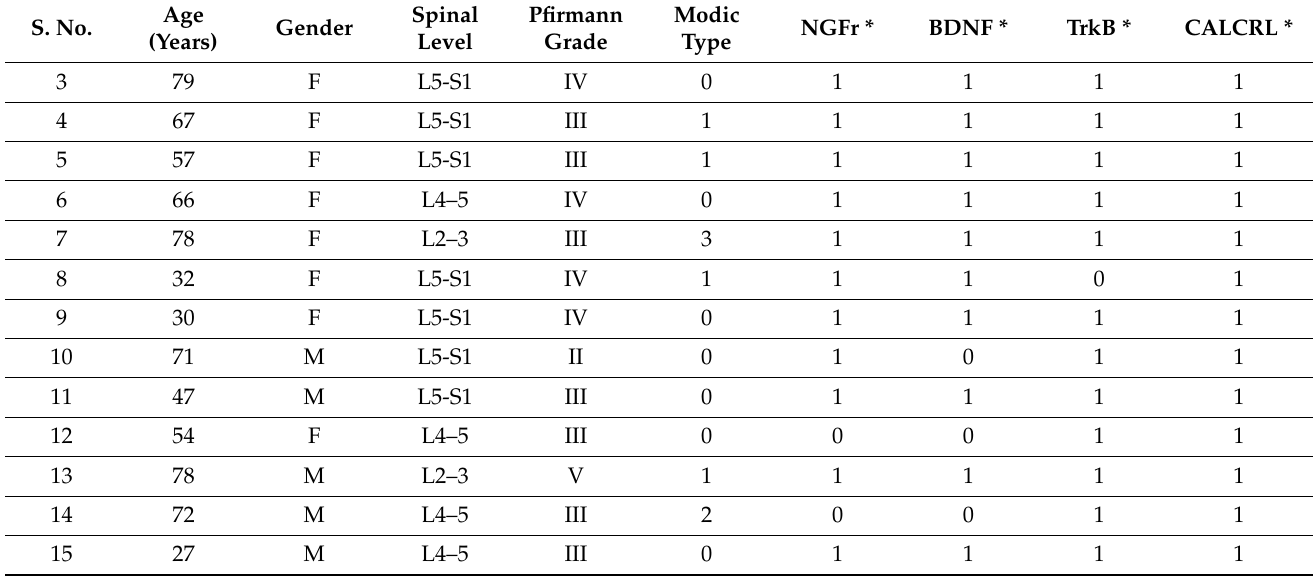
Table 1. Cont. Table 1. Human patient tissue donor characteristics and expression of neurotrophins (NGFr, BDNF, TrkB and CALCRL) in human degenerative IVD tissue sections.